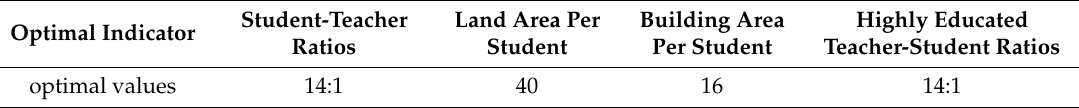
Table 2. A list of the optimal threshold’